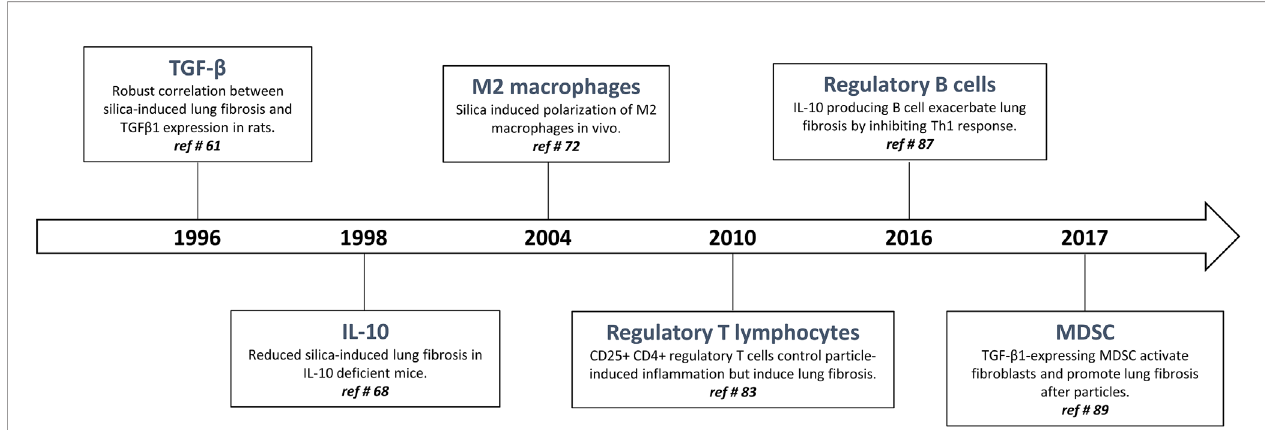
FIGURE 2 | Timeline: historical progression of immunoregulation in particle-induced lung fi brosis.